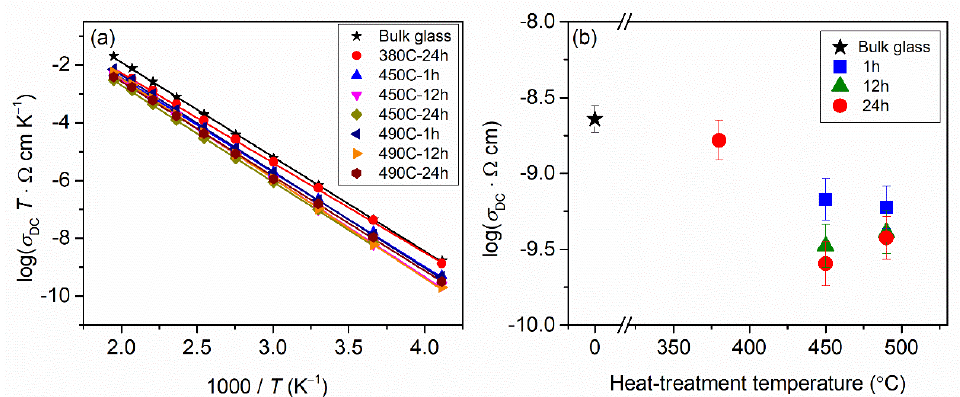
Table 3. DC conductivity, σ DC , at 30 °C and activation energy, E DC , for parent 40Na 2 O-30MoO 3 -